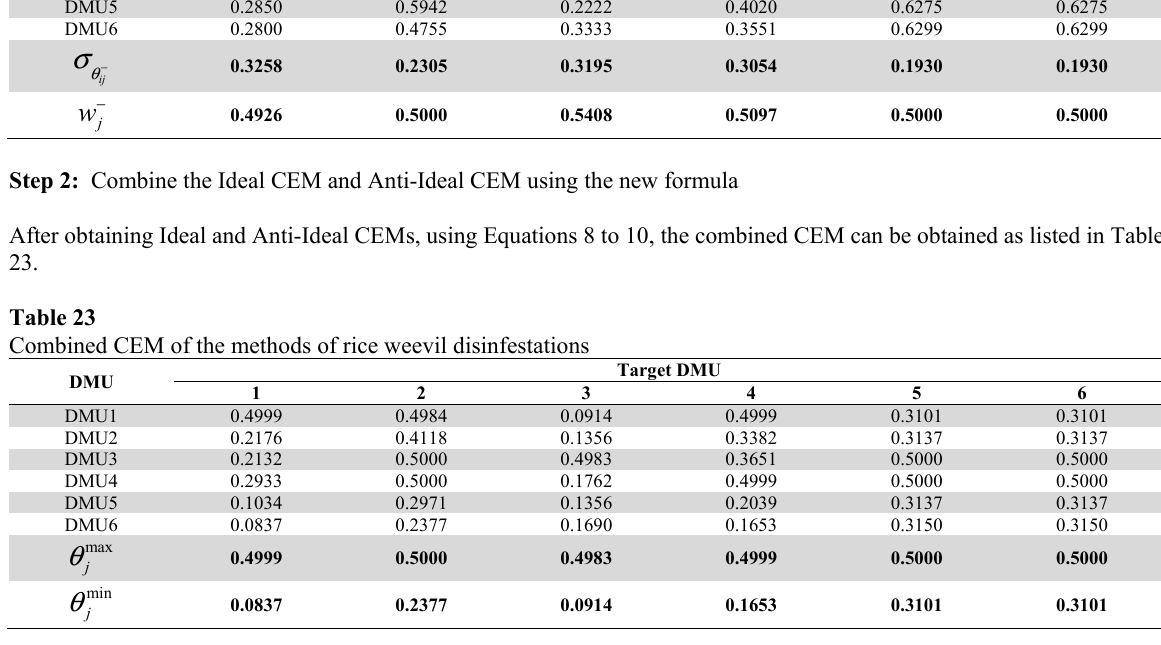
Step 3: Calculate the weights of DMUs based on CRITIC method and rank all DMUs